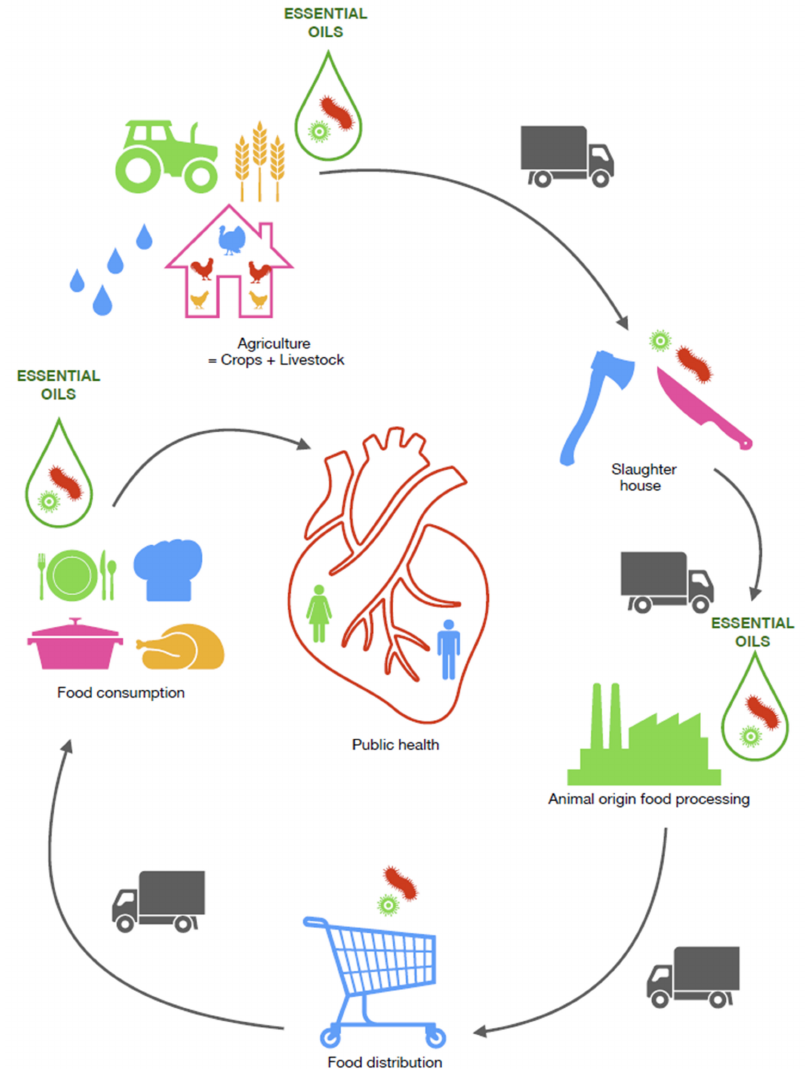
Figure 1. Possibilities of using essential oils in animal production “from stable to